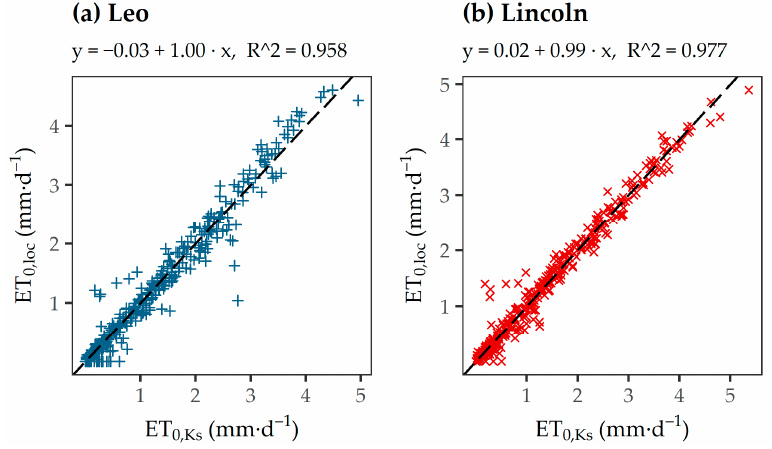
Figure 4. Parity plots with 1:1 reference line comparing daily ET 0, Ks and ET 0, loc in 2017 for ( a ) Leo and ( b ) Lincoln.